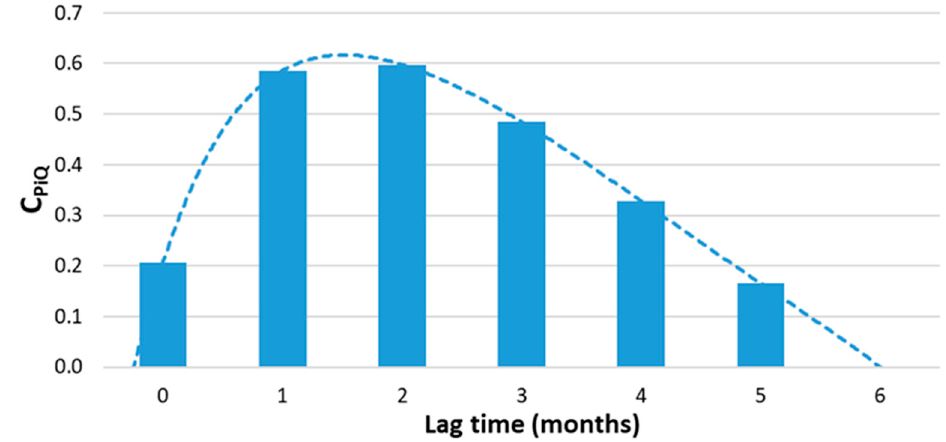
Figure 6. Cross-correlation coe ffi cients distribution for the Capodacqua di Spigno Spring obtained Figure 5. Cross-correlation coefficients distribution for the Capodacqua di Spigno Spring obtained for